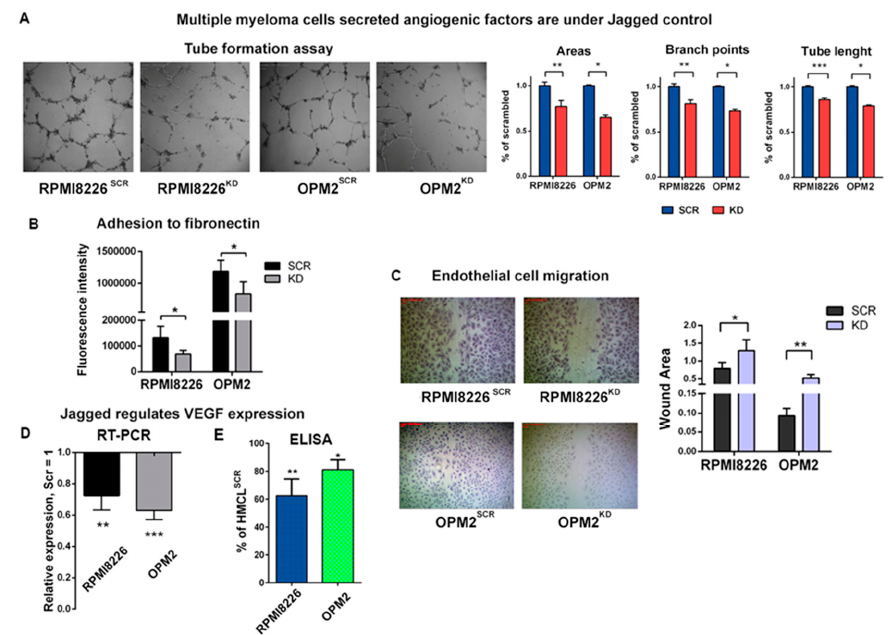
Figure 2. MM cell-derived Jagged promotes angiogenesis: ( A ) Tube formation assay on HPAECs with conditioned media (CM) of HMCLs SCR or HCMLs KD . 4X magnification images are shown on the left. Graphs (on the right) show the percentage variation of areas and branch points and total tube length +/-SEM. ( B ) Adhesion to fibronectin of HPAECs treated with CM from HMCLs SCR and HMCLs KD and stained with Calcein-AM. The graph reports the intensity of the adherent fluorescent cells. ( C ) Motility of the HPAECs treated with CM of HMCLs SCR and HMCLs KD was assessed by wound healing assays. Up: Representative pictures at 4X magnification. Down: The graph shows the average open area of the wounds expressed in pixels. ( D , E ) Variation of vascular endothelial growth factor (VEGF) expression in HMCLs SCR and HMCLs KD assessed at the mRNA level ( D ) by qRT-PCR of the relative gene expression variation (normalized to GAPDH) calculated by the 2 −ΔΔ Ct formula (data are expressed as the mean value ± SD) and at the protein levels ( E ) by ELISA on 48 h CM. Data are expressed as the amount of VEGF-A released by HMCLs KD normalized on VEGF-A expressed by HMCLs SCR . For each sample, the amount of VEGF-A (pg / mL) was normalized to the cell concentration. Statistical analyses were carried out by one-tailed t -tests; * is for p ≤ 0.05; ** is for p ≤ 0.01; *** is for p ≤